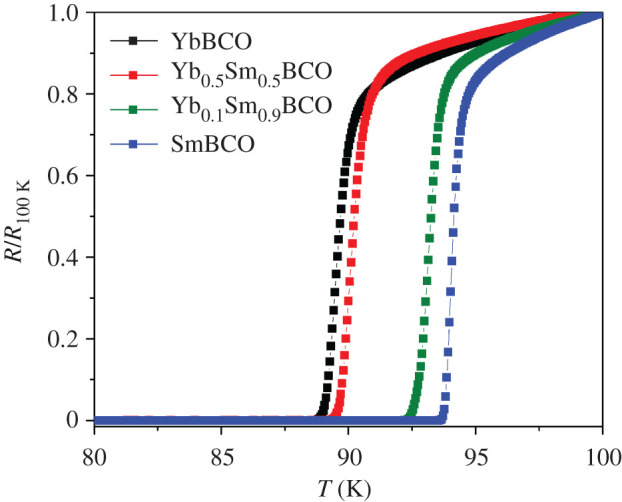
Normalized R(T) curves of Yb1−xSmxBa2Cu3O7−δ films grown with the parameters in table 1.